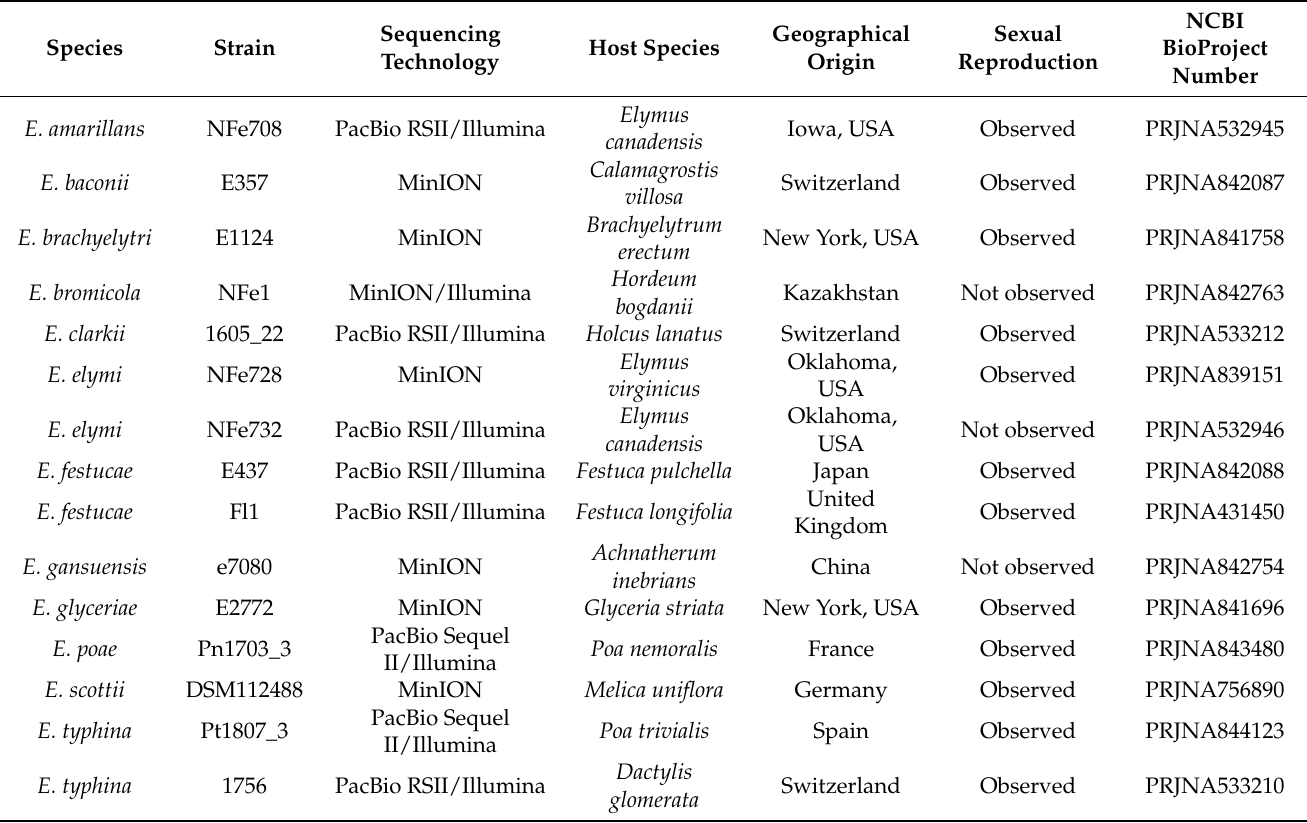
Table 1. Summary information for the 15 Epichloë